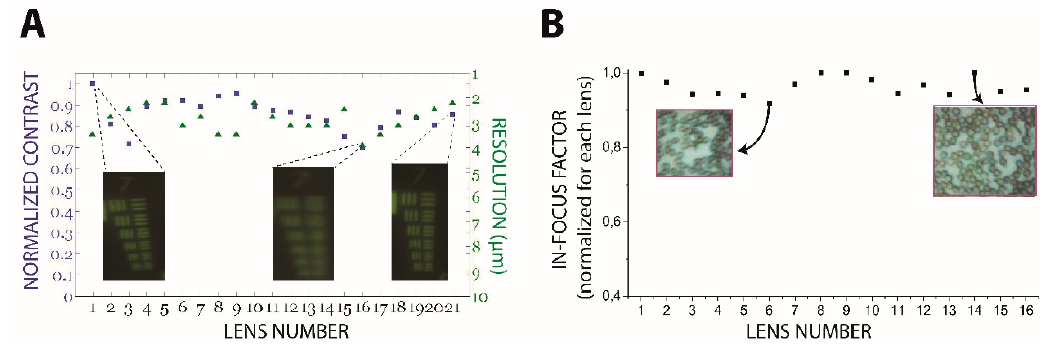
Figure 3. ( A ) Contrast and resolution distribution within the mini-lens array using a 1951 USAF resolution chart mask; ( B ) Normalized in-focus factor for each lens within the array, as measured by images obtained from a blood smear test. 5 lenses were excluded from this experiment as they did not produce high quality